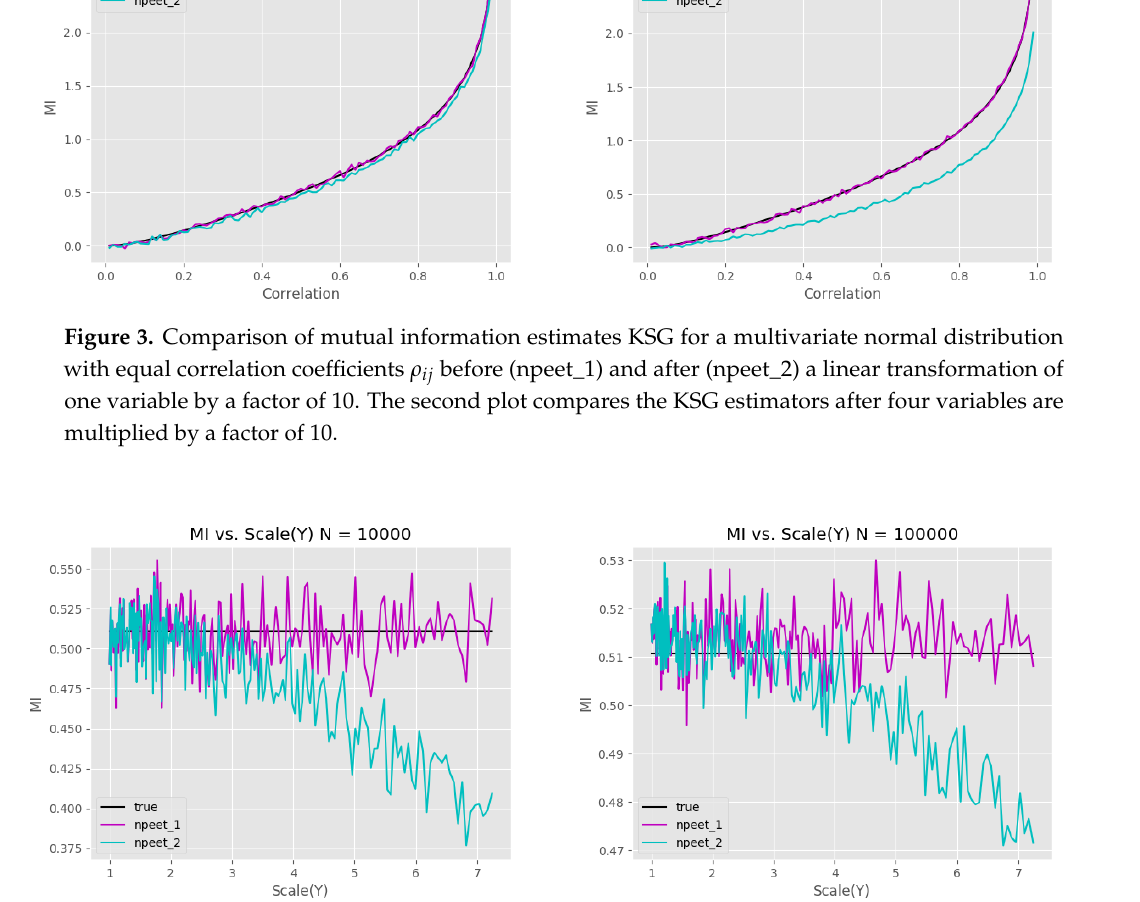
Figure 4. Comparison of true mutual information between the eight variables of a multivariate normal distribution where all correlation coefficients are equal to 1/2 (black line) and the value estimated from N = 10,000 and N = 100,000 samples before (npeet_1) and after (npeet_2) a linear transformation is applied to one variable x → x (cid:48) = 10 x